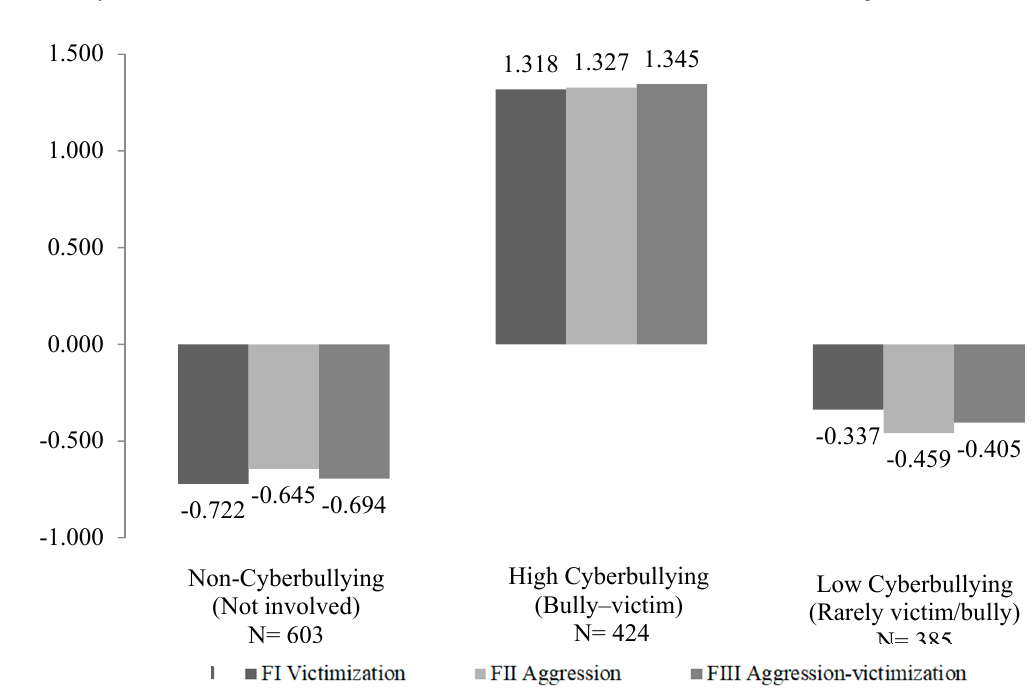
Table 3. Means and standard deviations of social anxiety between classes and statistical significance.